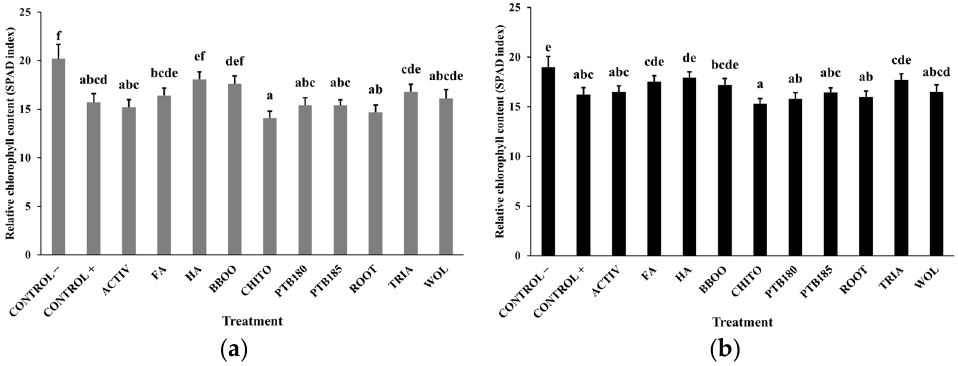
Figure 3. Effect of biostimulants on the chlorophyll content (SPAD index) of baby leaf lettuce grown in a substrate inoculated with Pythium ultimum under organic ( a ) and conventional ( b ) management. The substrate was drenched with Ascophyllum nodosum extract (ACTIV), fulvic acid (FA), humic acid (HA), bamboo vinegar (BBOO), chitosan (CHITO), Bacillus pumilus PTB180 (PTB180), Bacillus subtilis PTB185 (PTB185), Trichoderma harzianum T ‐ 22 (ROOT), triacontanol (TRIA), or wollastonite (WOL). Control seeds were sown in a substrate that was drenched with water (no biostimulants) and inoculated with P. ultimum (CONTROL +) or non ‐ inoculated with P. ultimum (CONTROL − ). Each value represents the mean of 8 replicates ± standard error. The means sharing a same letter are not significantly different according to Fisher’s protected LSD test ( p ≤ 0.05).